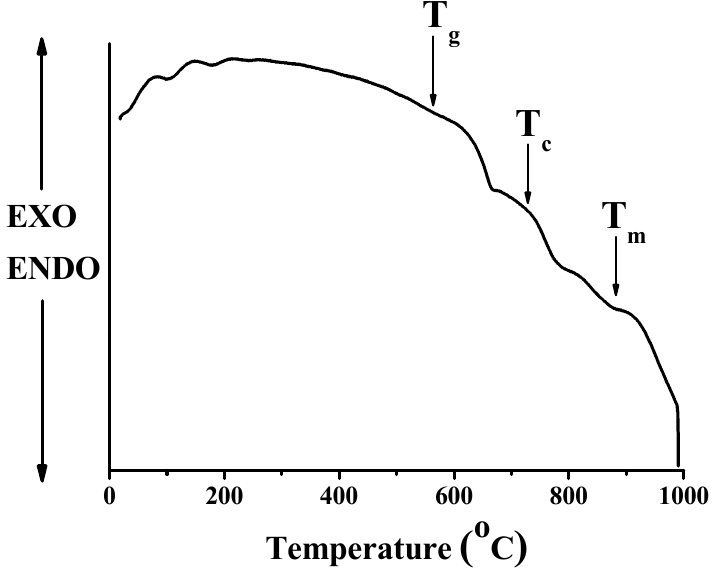
Figure 3. Differential scanning calorimetry (DSC) thermogram of S35654.